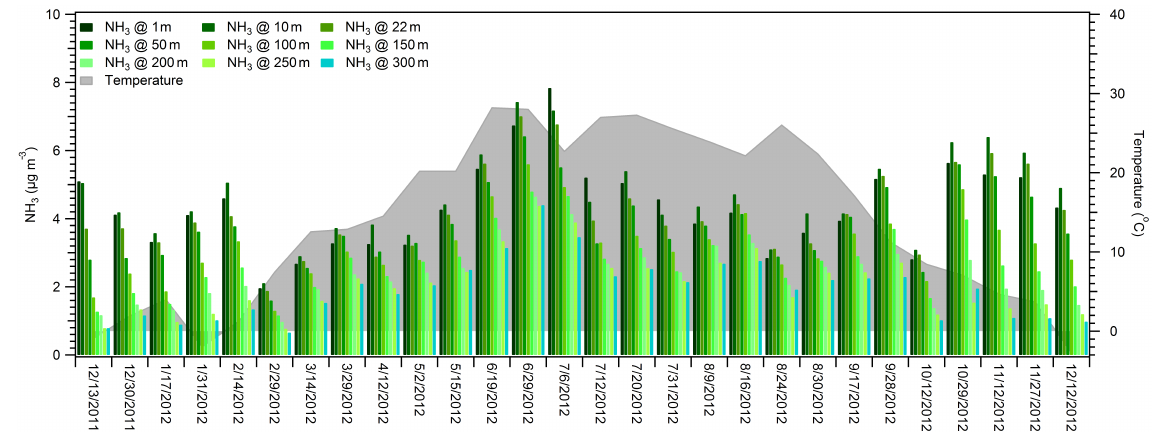
Figure 4. Time series of vertical distribution of NH 3 concentrations and surface temperature measured at the BAO tower from 13 December 2011 to 9 January 2013.